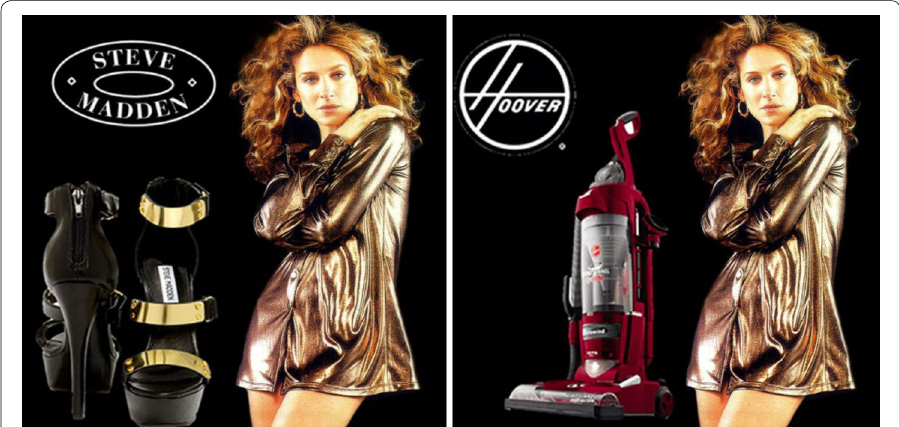
Fig. 4 Sarah Jessica Parker‑Steven Madden and Sarah Jessica